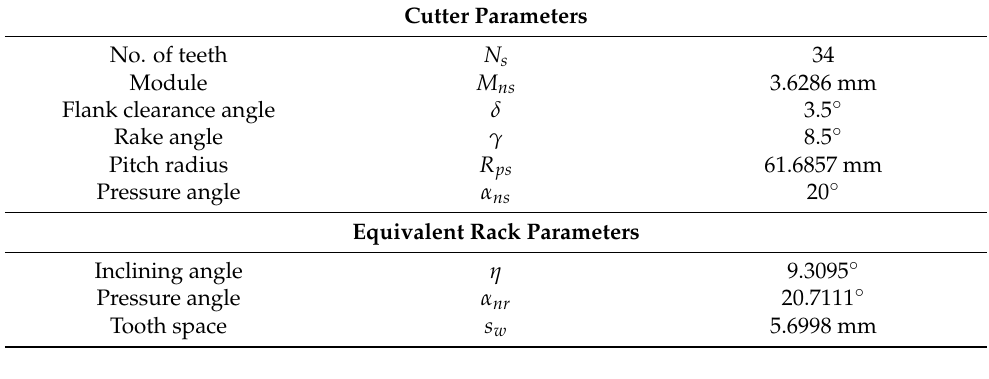
Table 1. Parameters of the spur shaping cutter and the equivalent rack.